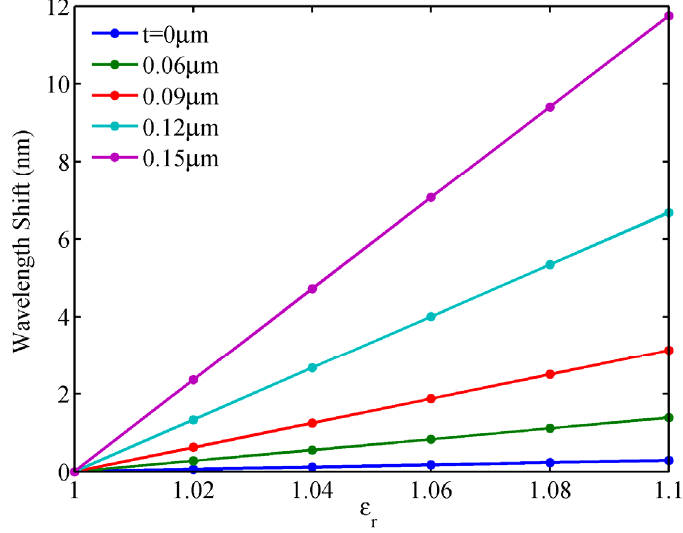
ε and wavelength shift for a variation of r